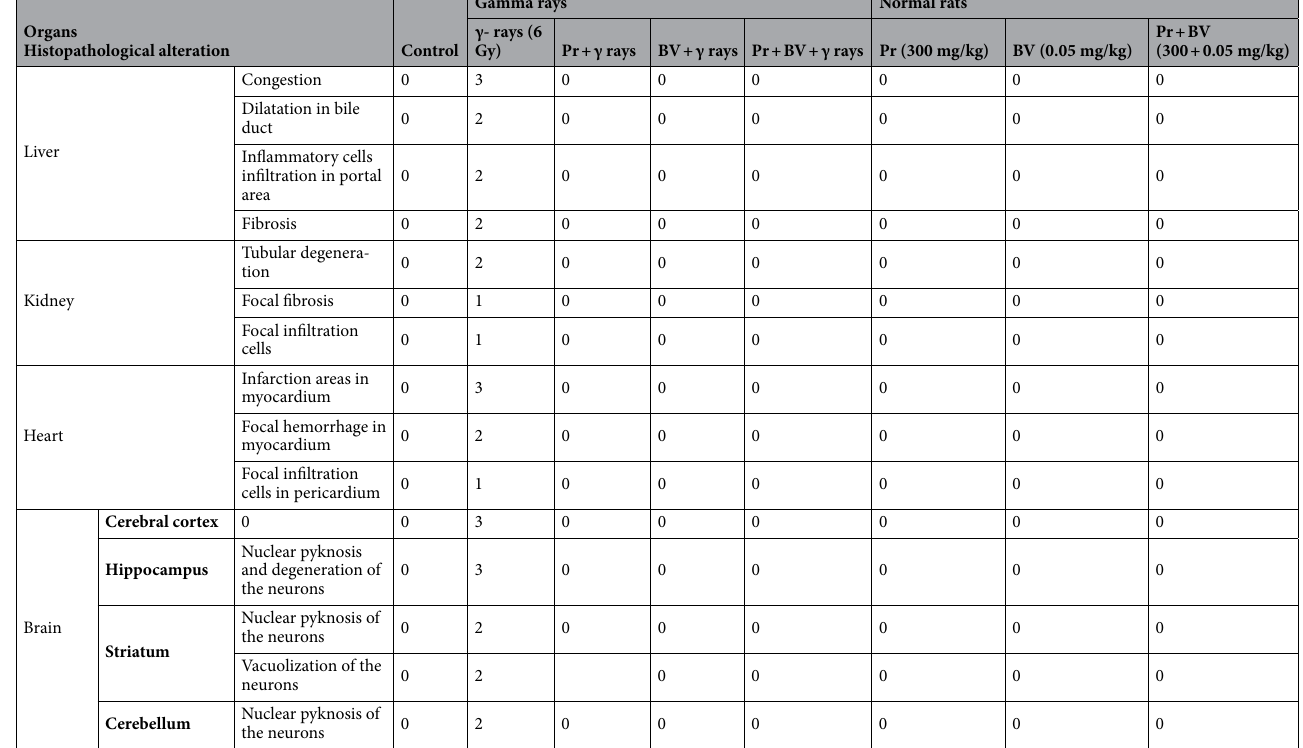
Table 6. Histopathological changes in the heart of male rats exposed to γ- rays and the treatment effect of propolis and/or bee venom, based on scoring the severity of the injury. Normal (0), moderate (2), mild (1) severe